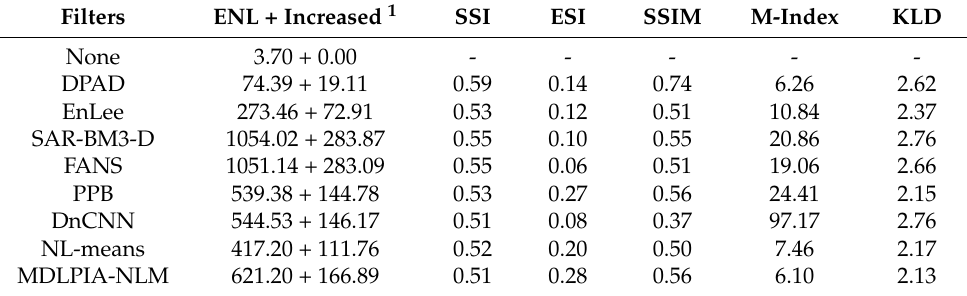
Table 2. Index evaluation for the simulated